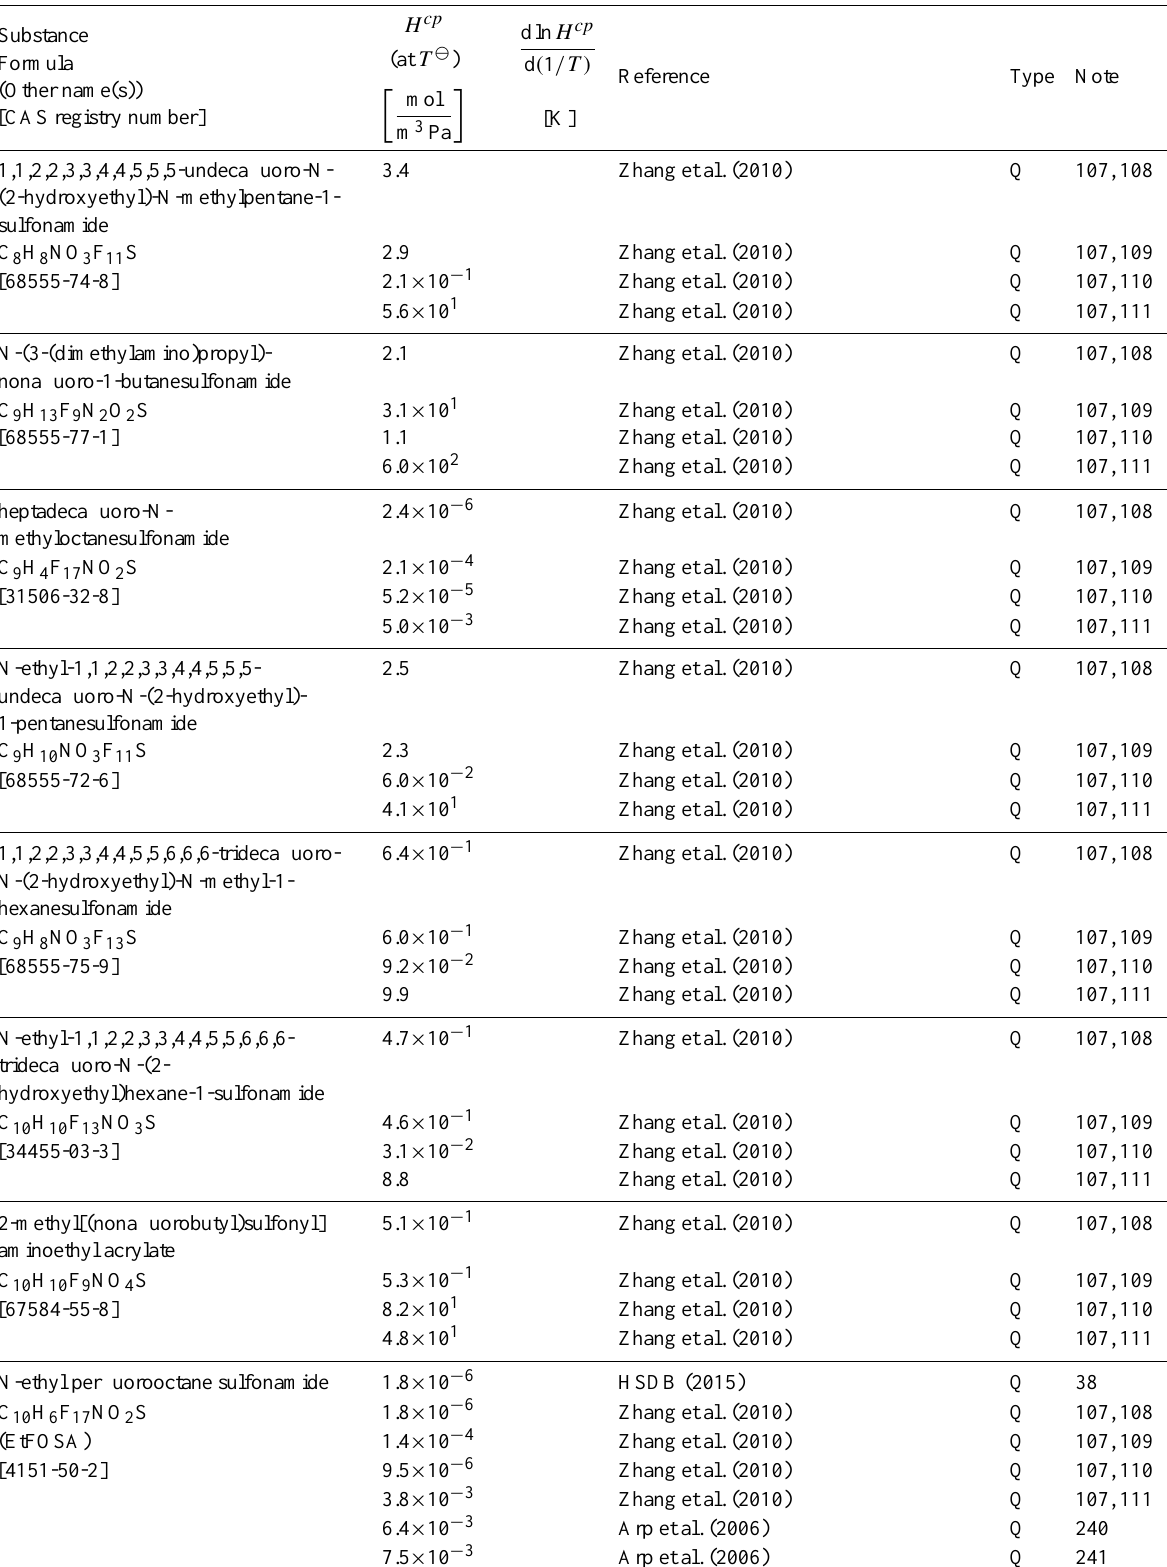
Table 6: Henry’s law constants for water as solvent